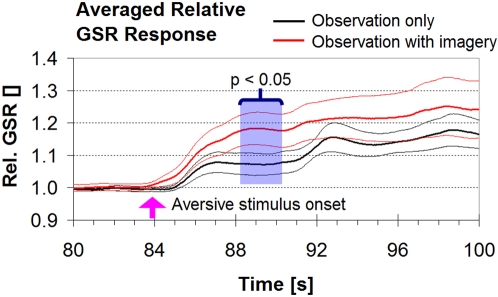
Averaged relative GSR for the two groups (red: observe and imagine, black: observe only).Thin lines indicate ±1 standard error. The blue shaded area indicates the time period (88.1–90.1 s) during which the observation-with-imagery group is significantly higher than the observation-only group (p<0.05). The time of onset of the aversive stimulus is shown as a violet arrow on the abscissa. The ordinate shows the averaged GSR relative to baseline, measured for 16 seconds prior to the onset of the aversive stimulus (see Methods).